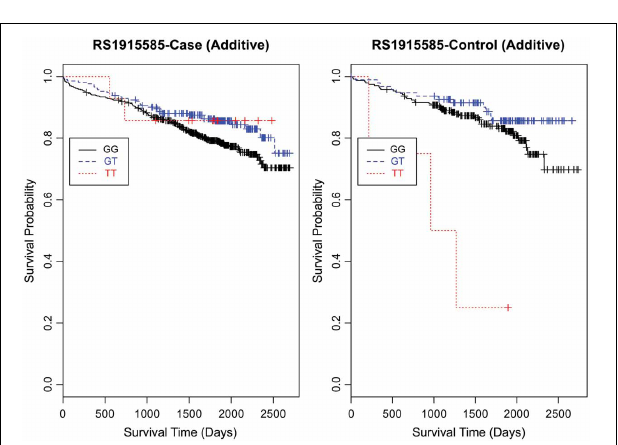
FIGURE 5 | Kaplan–Meier survival curves for CAD cases vs. controls in dominant (allele) model for LSAMP SNP rs1462845. X -axis displays the number of days from index catheterization to death (all-cause mortality). Y -axis displays the Kaplan–Meier survival probability by genotype. G is the minor allele; AA, wild-type genotype (reference; black curve), and red curve indicates AG and GG genotypes